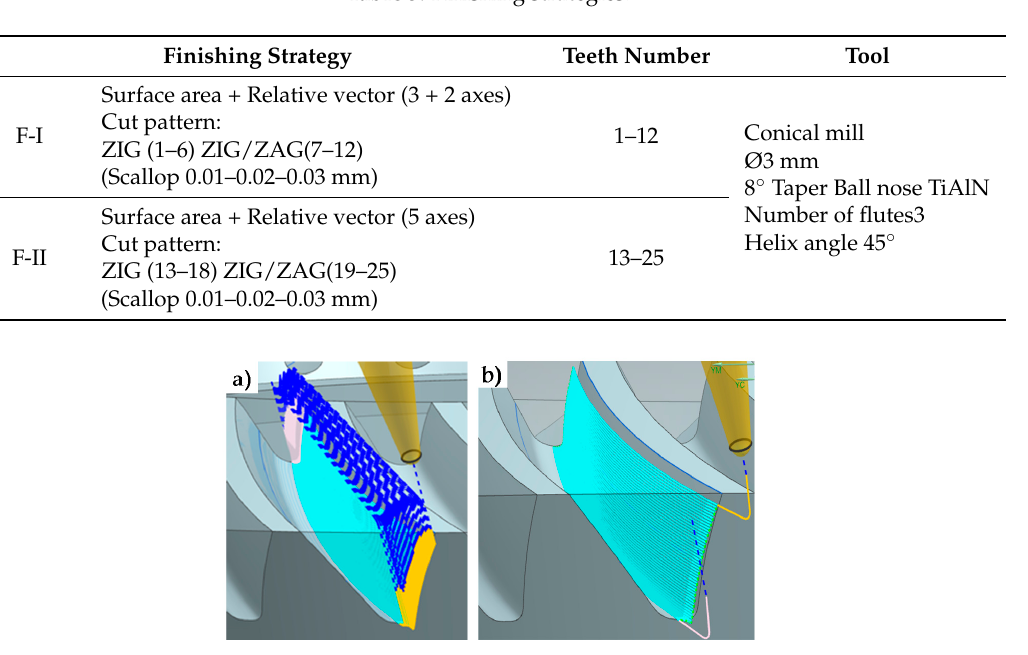
Figure 2. R-I ( a ) and R-II ( b ) roughing strategies.